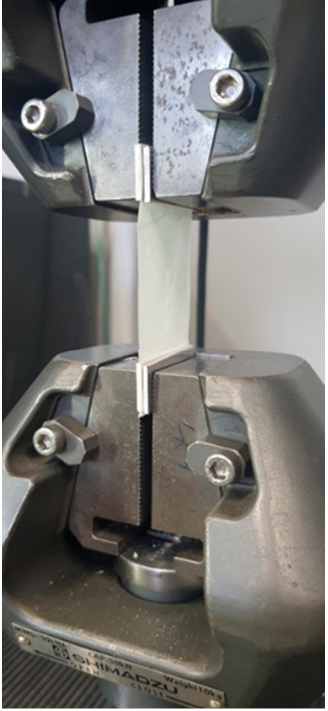
Figure 1. Tensile test specimen on the test machine.